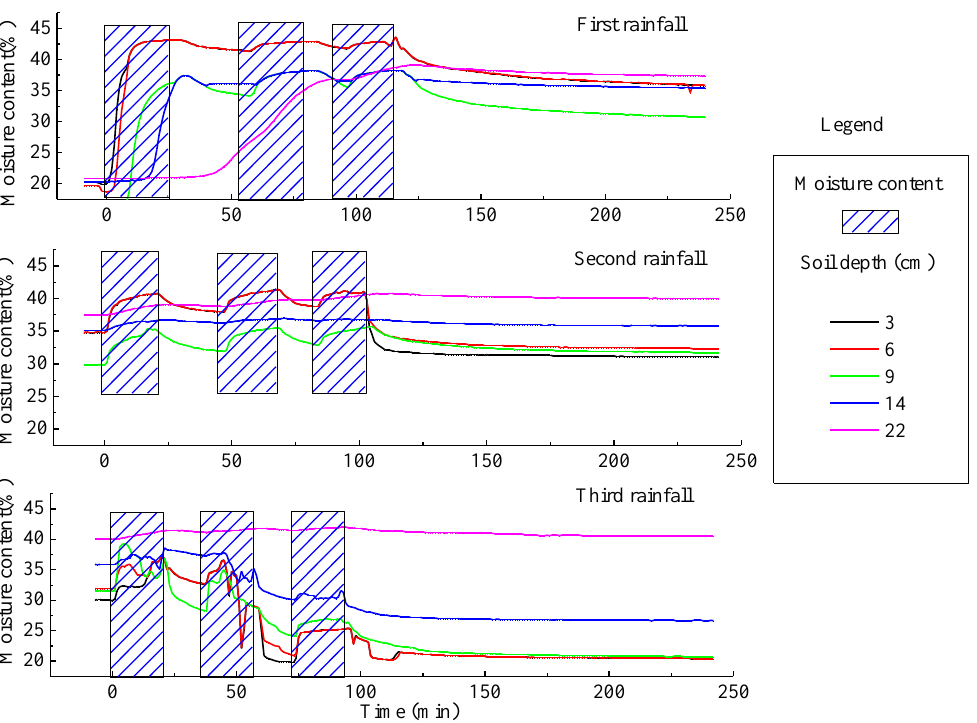
Figure 9. Dynamic change process of soil water content of the sand-covered slope at a rainfall density of 2.0 mm/min.